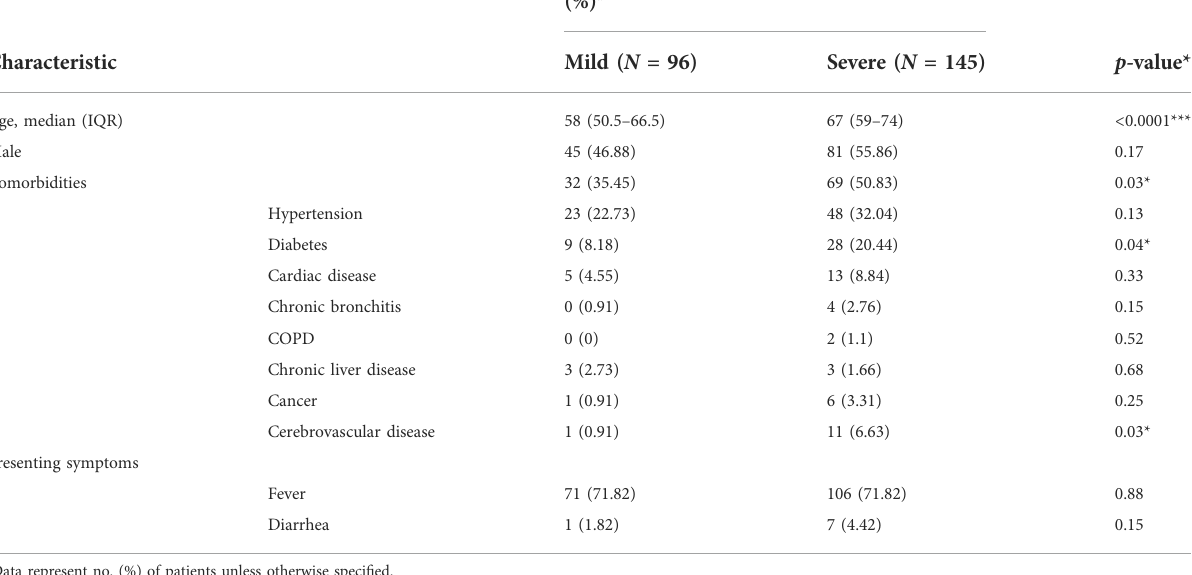
TABLE 1 Patient demographics by clinical phenotype.